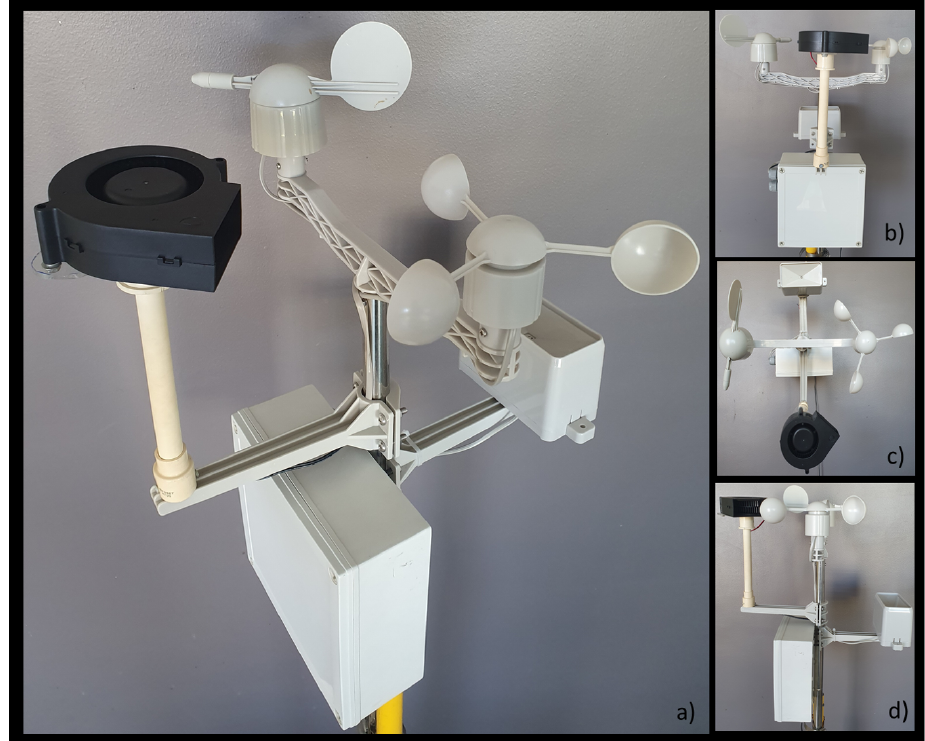
Figure 7. MEIoT weather station with exogenous disturbance input. ( a ) Isometric view, ( b ) front view, ( c ) top view and ( d ) right view.